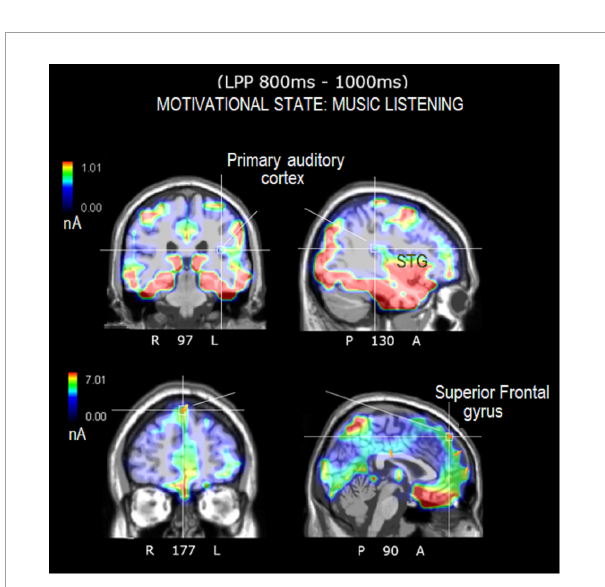
FIGURE8 Axial, sagittal, and coronal brain sections showing the location and strength of electromagnetic dipoles explaining the surface LPP potential during the music-listening desire condition. Note that the participants were in complete silence inside an anechoic chamber during EEG